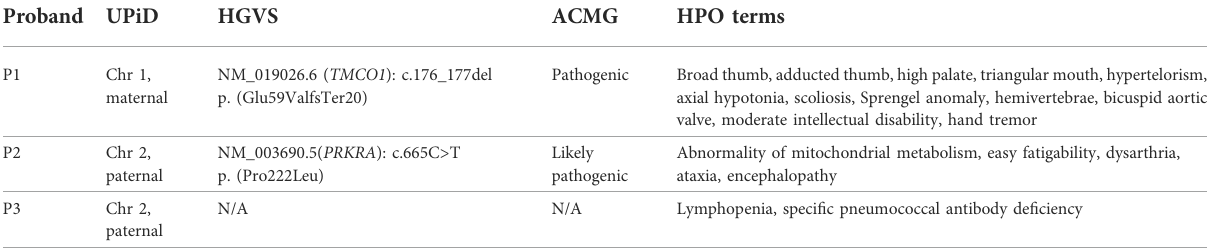
TABLE 1 Summary of clinical features and analysis results. Phenotype column shows HPO terms used in analysis. Proband UPiD